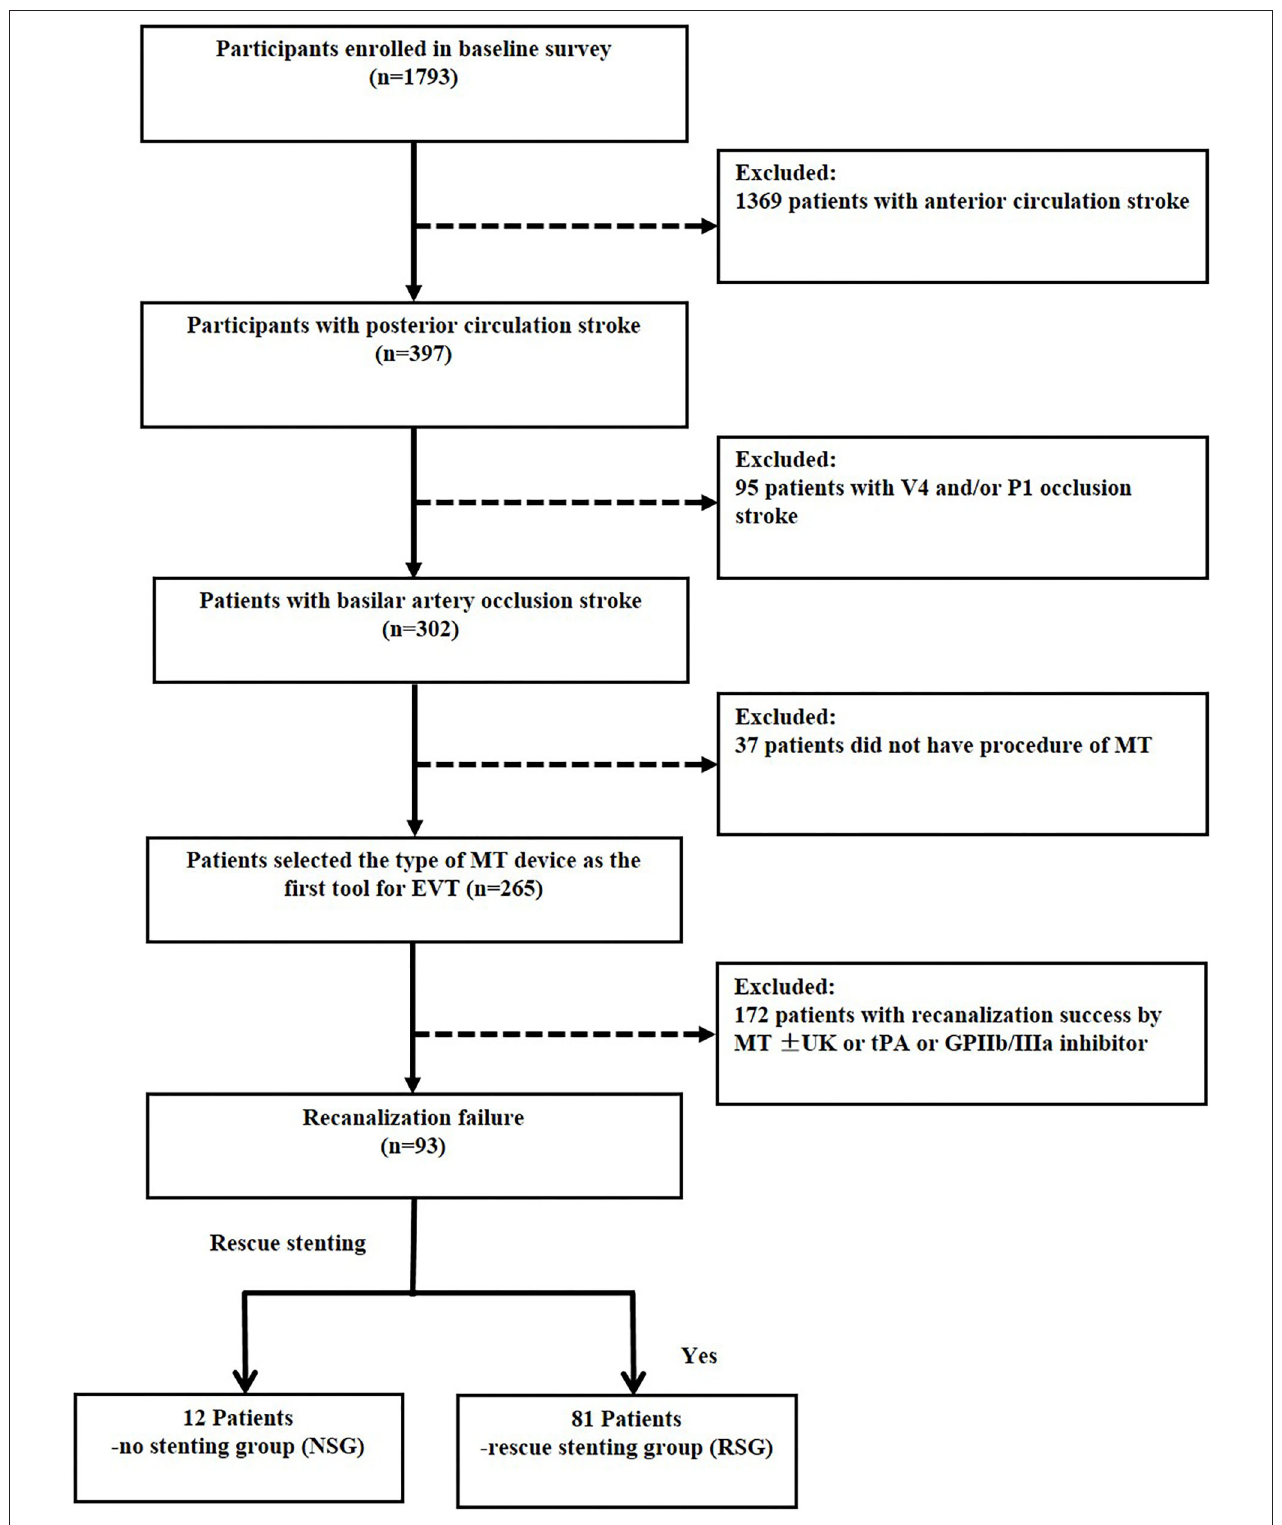
FIGURE 1 | Flow chart of patient inclusion. MT indicates mechanical thrombectomy; V4, forth segment of vertebral artery; P1, first segment of posterior cerebral artery. Recanalization success, modified Tissue Thrombolysis in Cerebral Ischemia, 2b − 3.